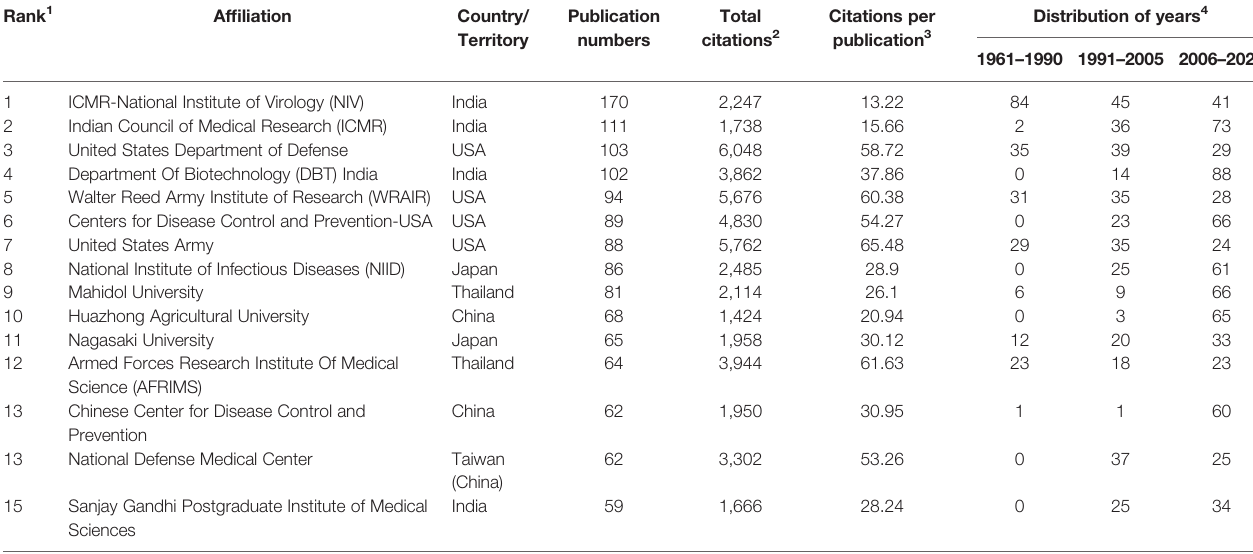
TABLE 4 | Top 15 Af fi liations with the most publications.